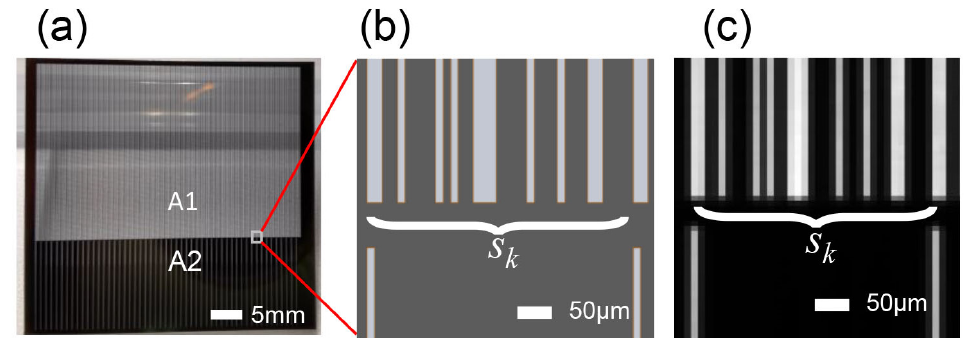
Figure 5. The layout of the slits on the code board. ( a ) A photo of the coding plate, on which a coded slit is in the region A1 and the region A2 contains uniform slits with 0.455 mm intervals between each slit. ( b ) The designed coding slits. ( c ) Part of an image on the detector corresponding to ( b ) at 543 ( ± 10) nm monochromatic